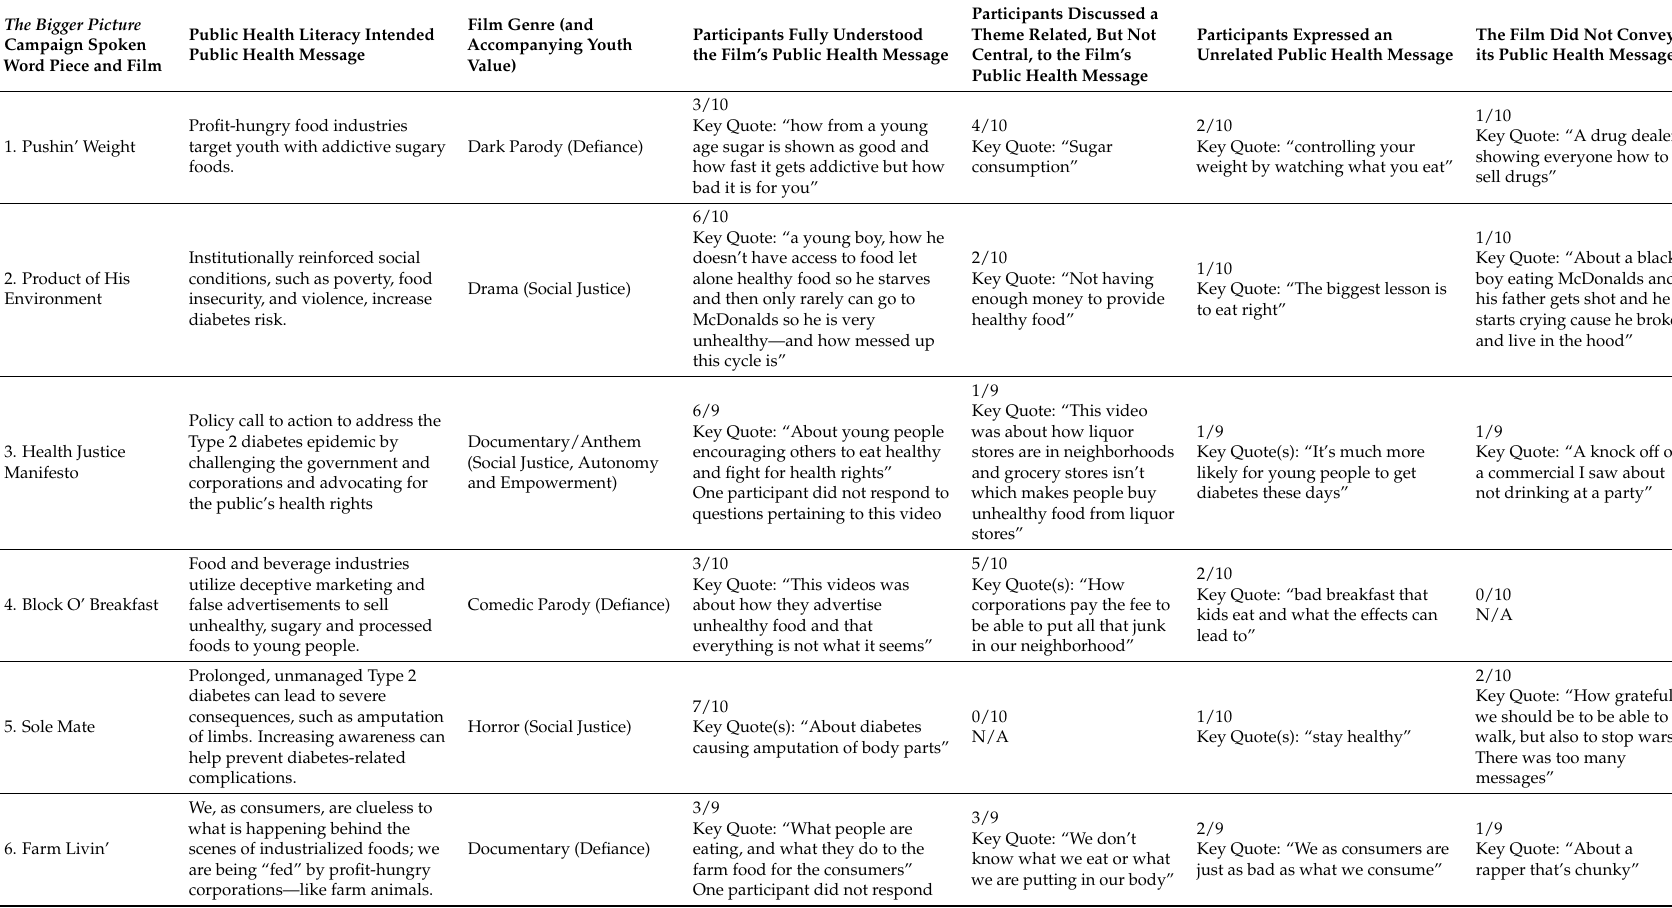
Table 1. Representative Bigger Picture Campaign Messages a , Associated Adolescent Values, and Extent of PSAs’ Success in Conveying Messages. The Bigger Picture Campaign Spoken Word Piece and